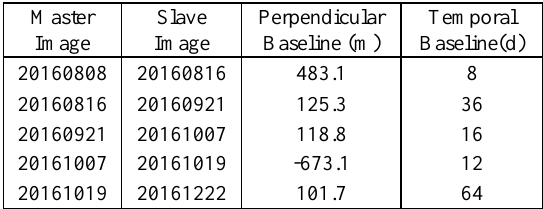
Table 1. COSMO-SkyMed image